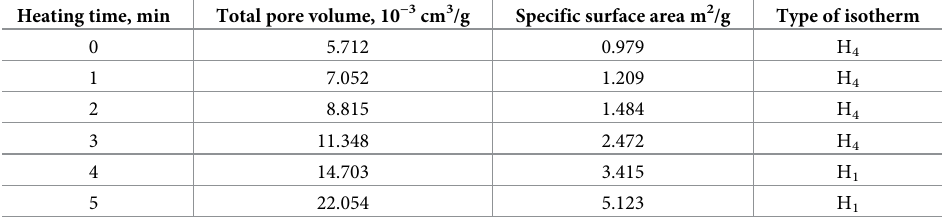
Table 3. Pore volume, specific surface area, and types of isotherms of marine shale samples obtained at different electromagnetic radiation time.